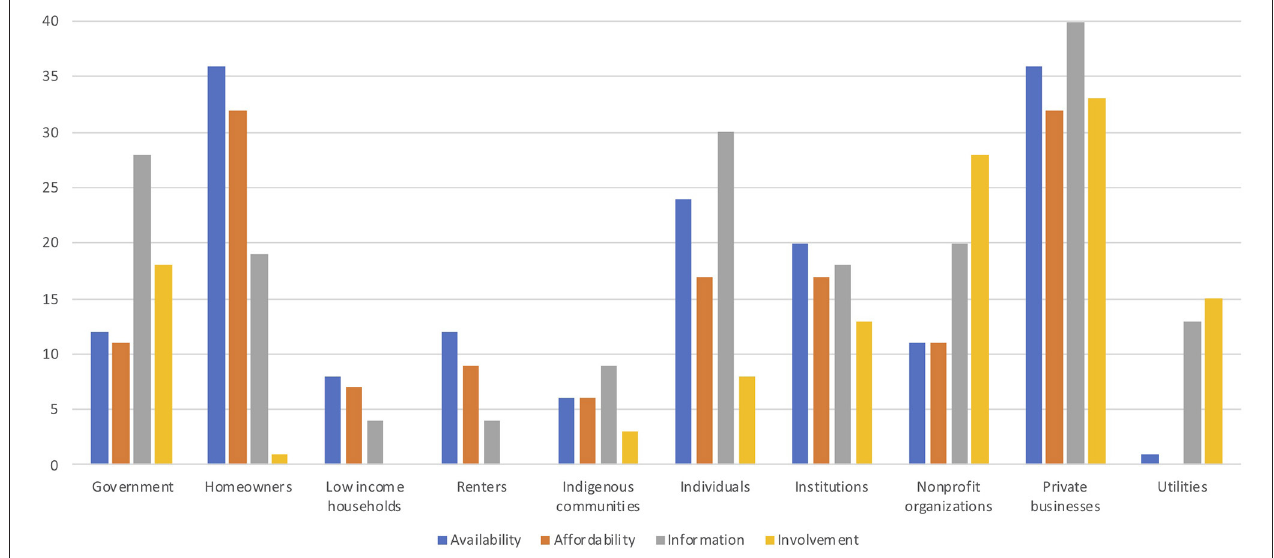
FIGURE 1 | Frequencies of energy justice indicators across innovations by user